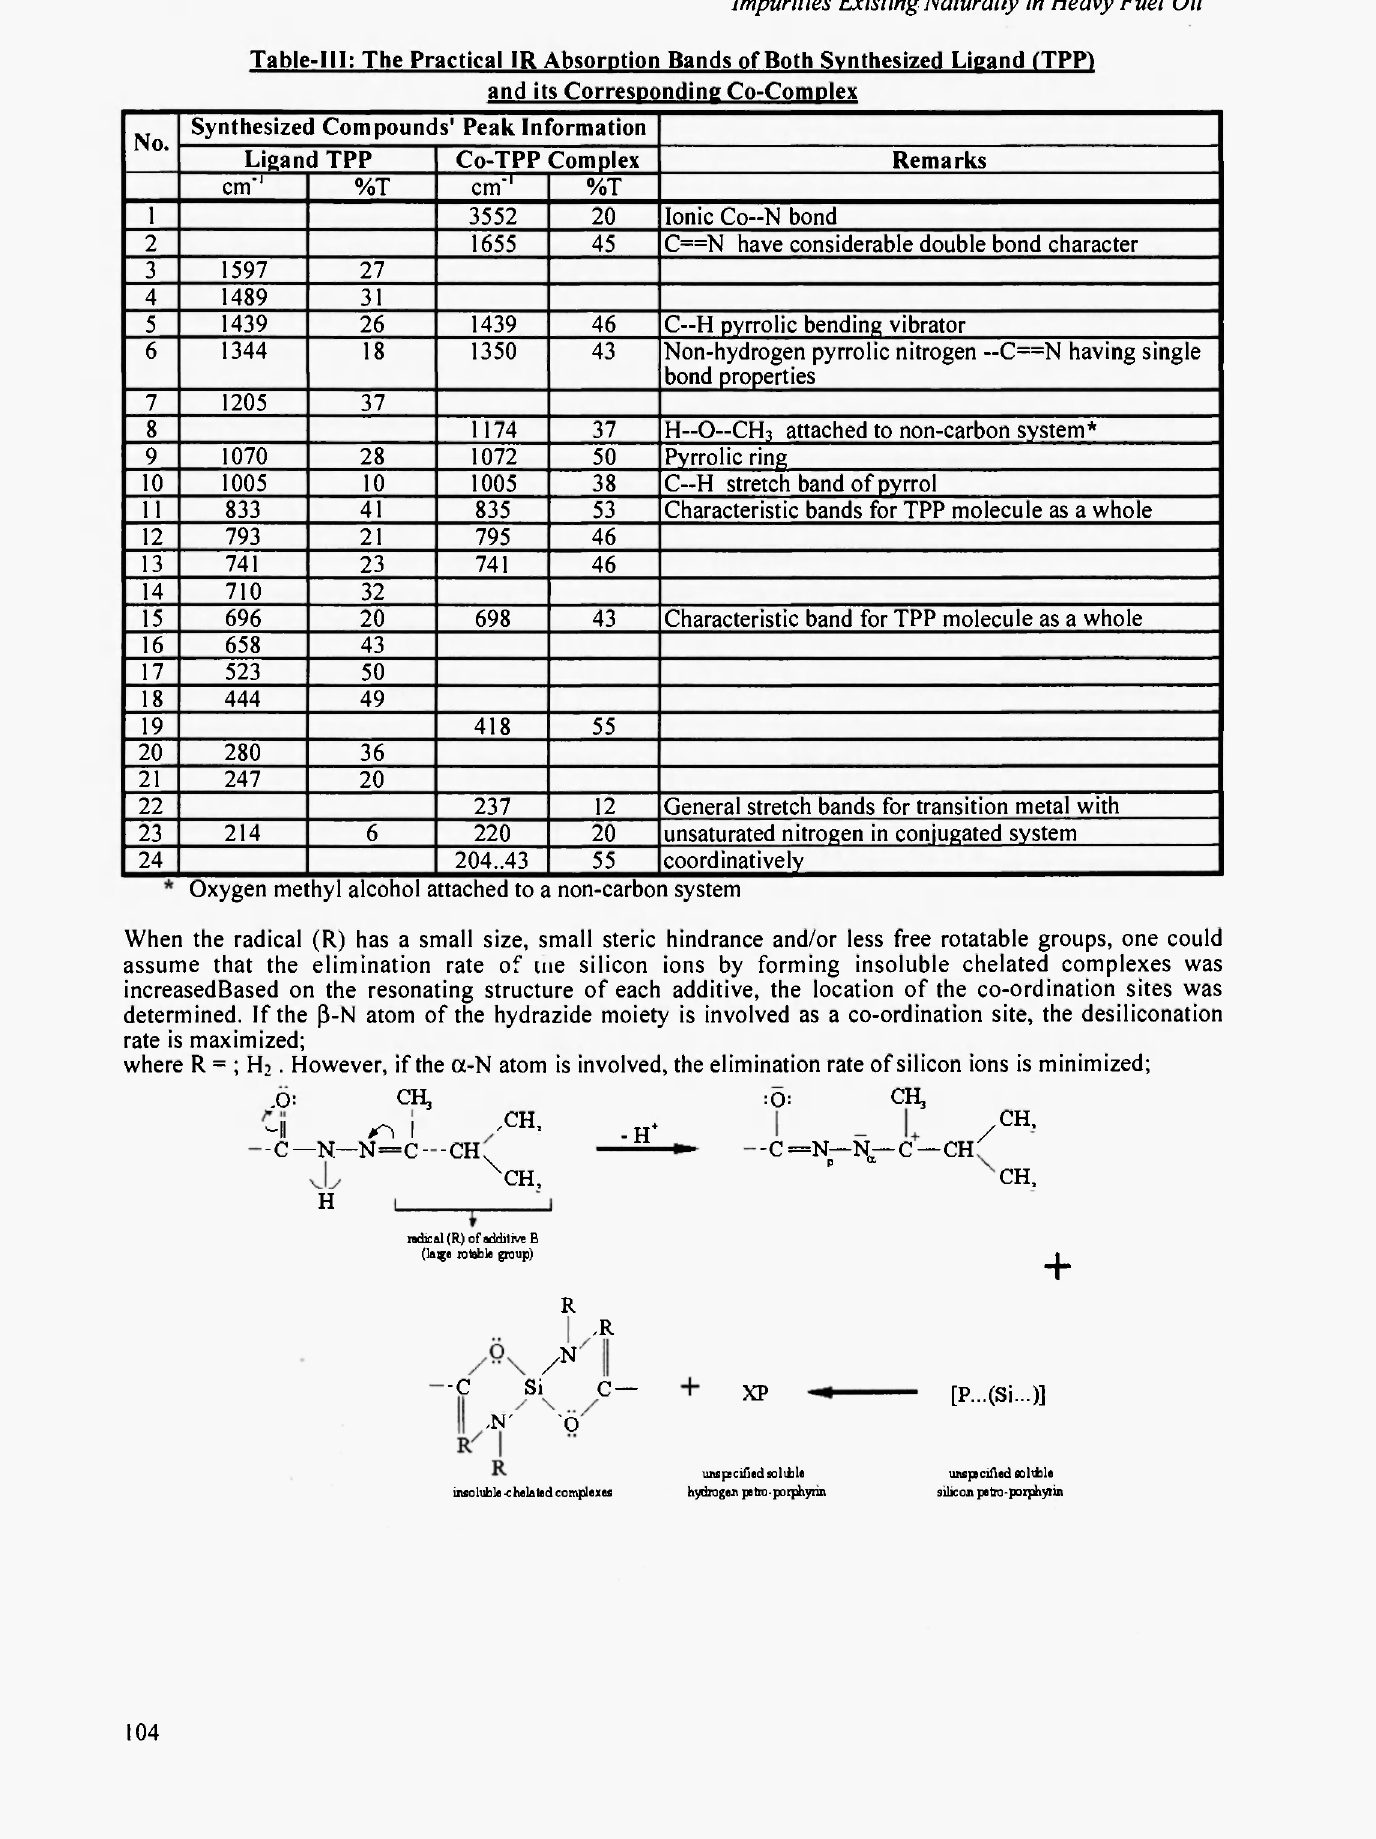
Table-Ill: The Practical IR Absorption Bands of Both Synthesized Ligand ΓΓΡΡ) and its Corresponding